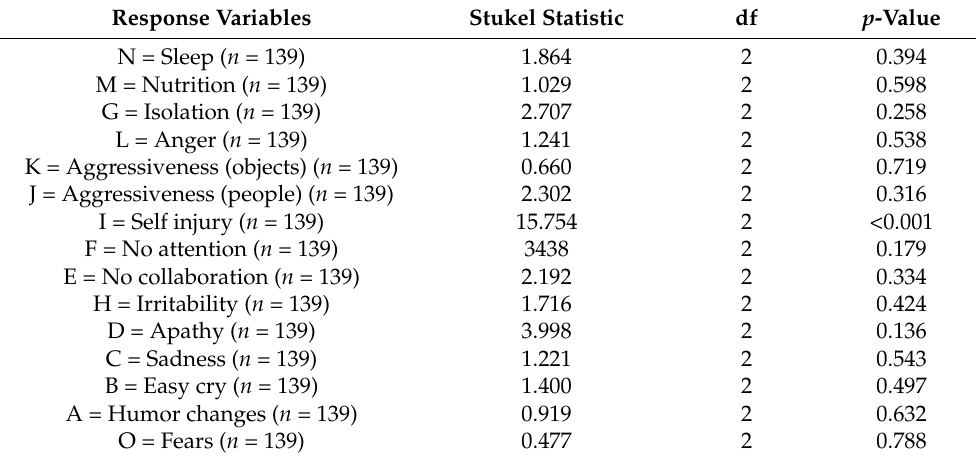
Table 4. Goodness-fit-of test for each